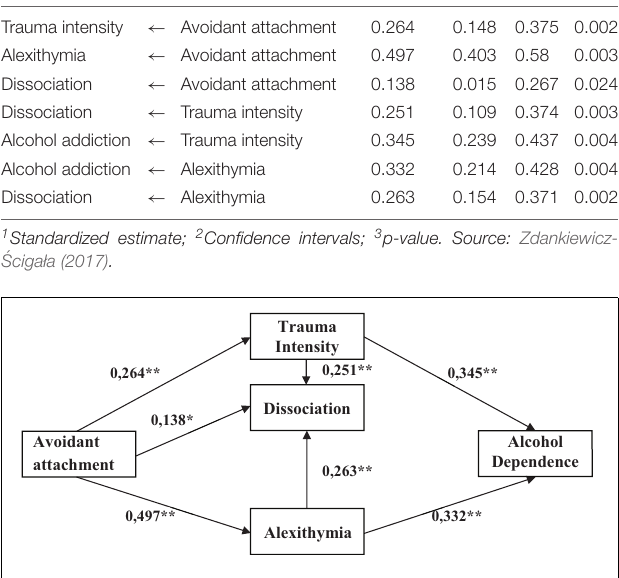
FIGURE 5 | Standardized estimates for models taking into account the avoidant attachment style. * p < 0.05 and ** p < 0.01. Source: Zdankiewicz- ´Scigała